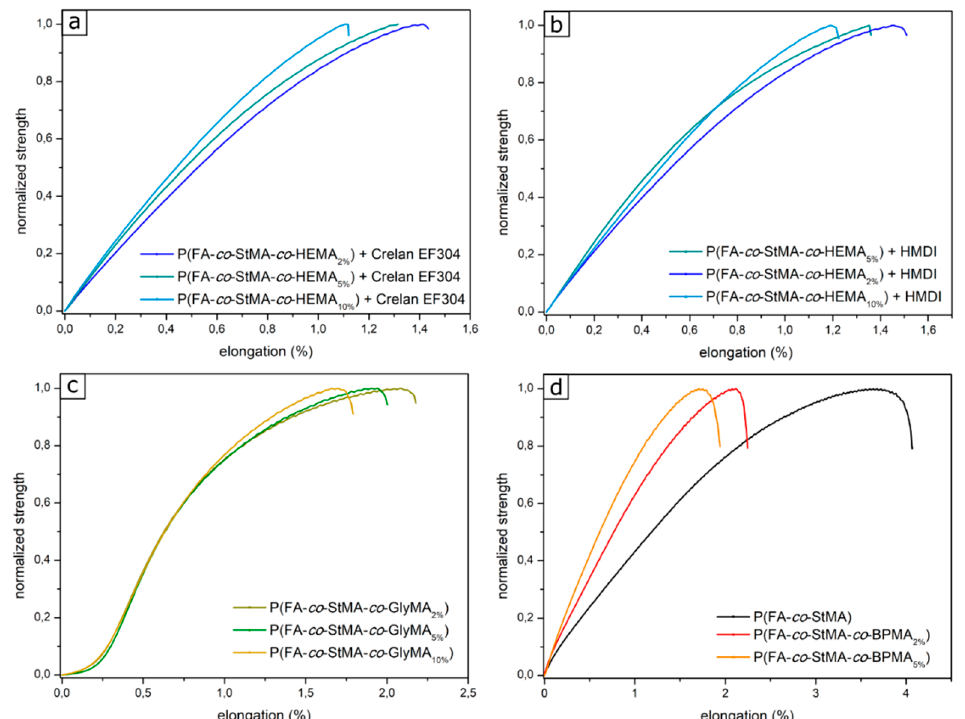
Figure 8. Elasticity plot of the cross-linked cellulose fibers coated with ( a ) P(FA- co -StMA- co -HEMA) cross-linked with Crelan EF403, ( b ) P(FA- co -StMA- co -HEMA) cross-linked with HMDI, ( c ) P(FA- co -StMA- co -GlyMA) thermal-induced cross-linked, and ( d ) P(FA- co -StMA- co -BPMA) UV-induced cross-linked, as well as the non-cross-linked fibers.